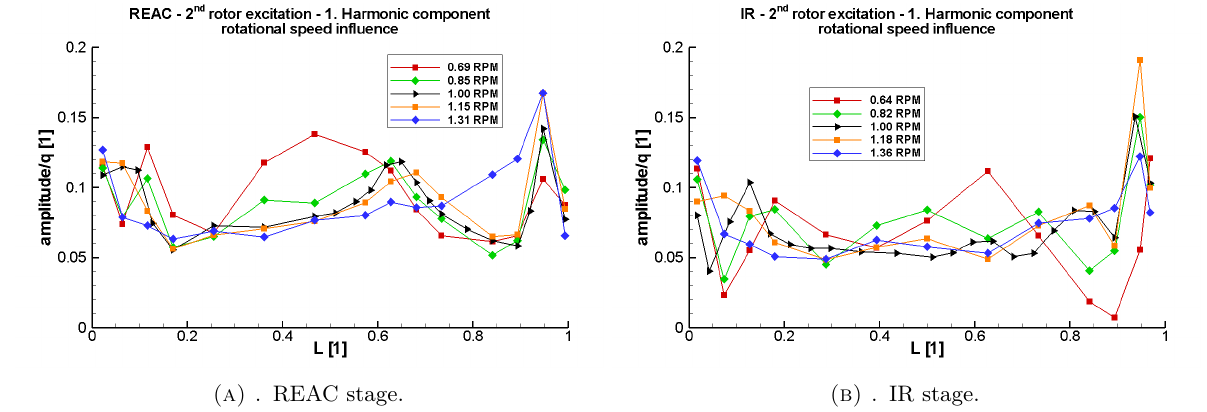
Figure 7. The second rotor excitation - influence of rotational